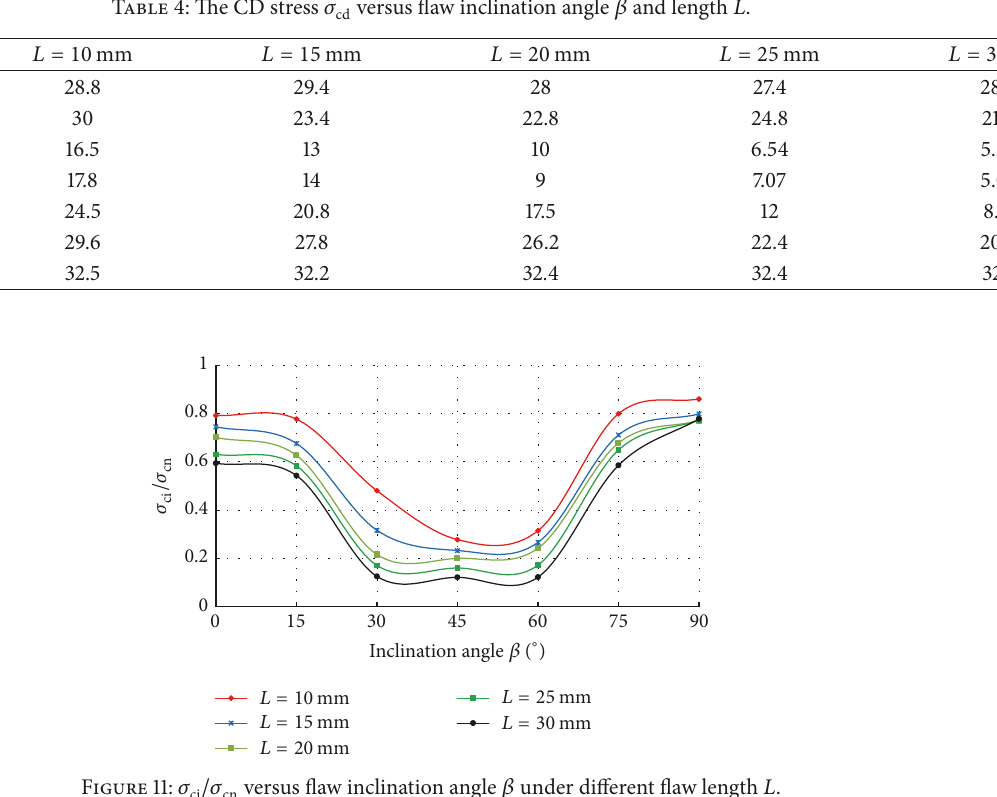
Figure 11: 𝜎 ci /𝜎 cn versus flaw inclination angle 𝛽 under different flaw length 𝐿 .